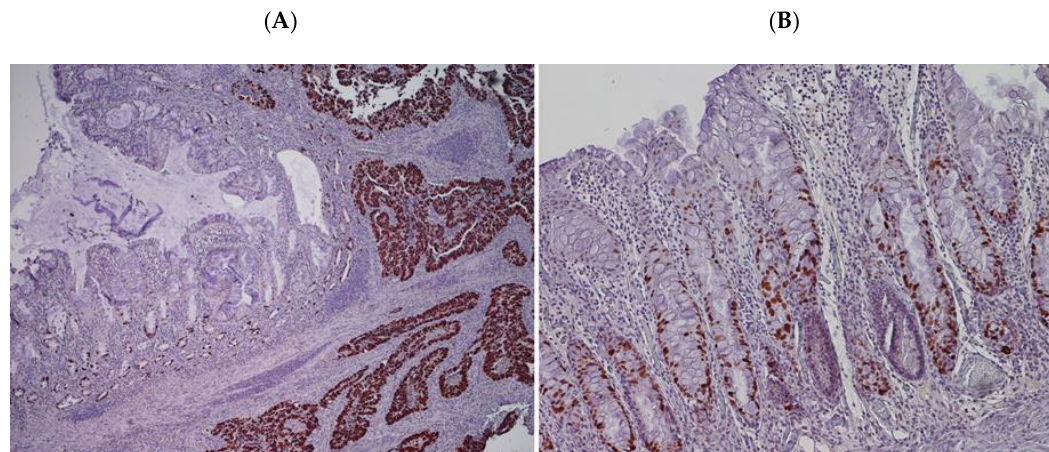
Figure 6. ( A ) “Positive-pattern” of p53 in PSRT tumor sample (right). Few scattered p53-positive cells in mucosa with acute radiation-damage (left) (p53 immunostaining) (100 times magnified); ( B ) Scattered p53-positive cells in the deep portion of glandular epithelium of radiation-damaged non-neoplastic mucosa in PSRT (p53 immunostaining) (200 times magnified).